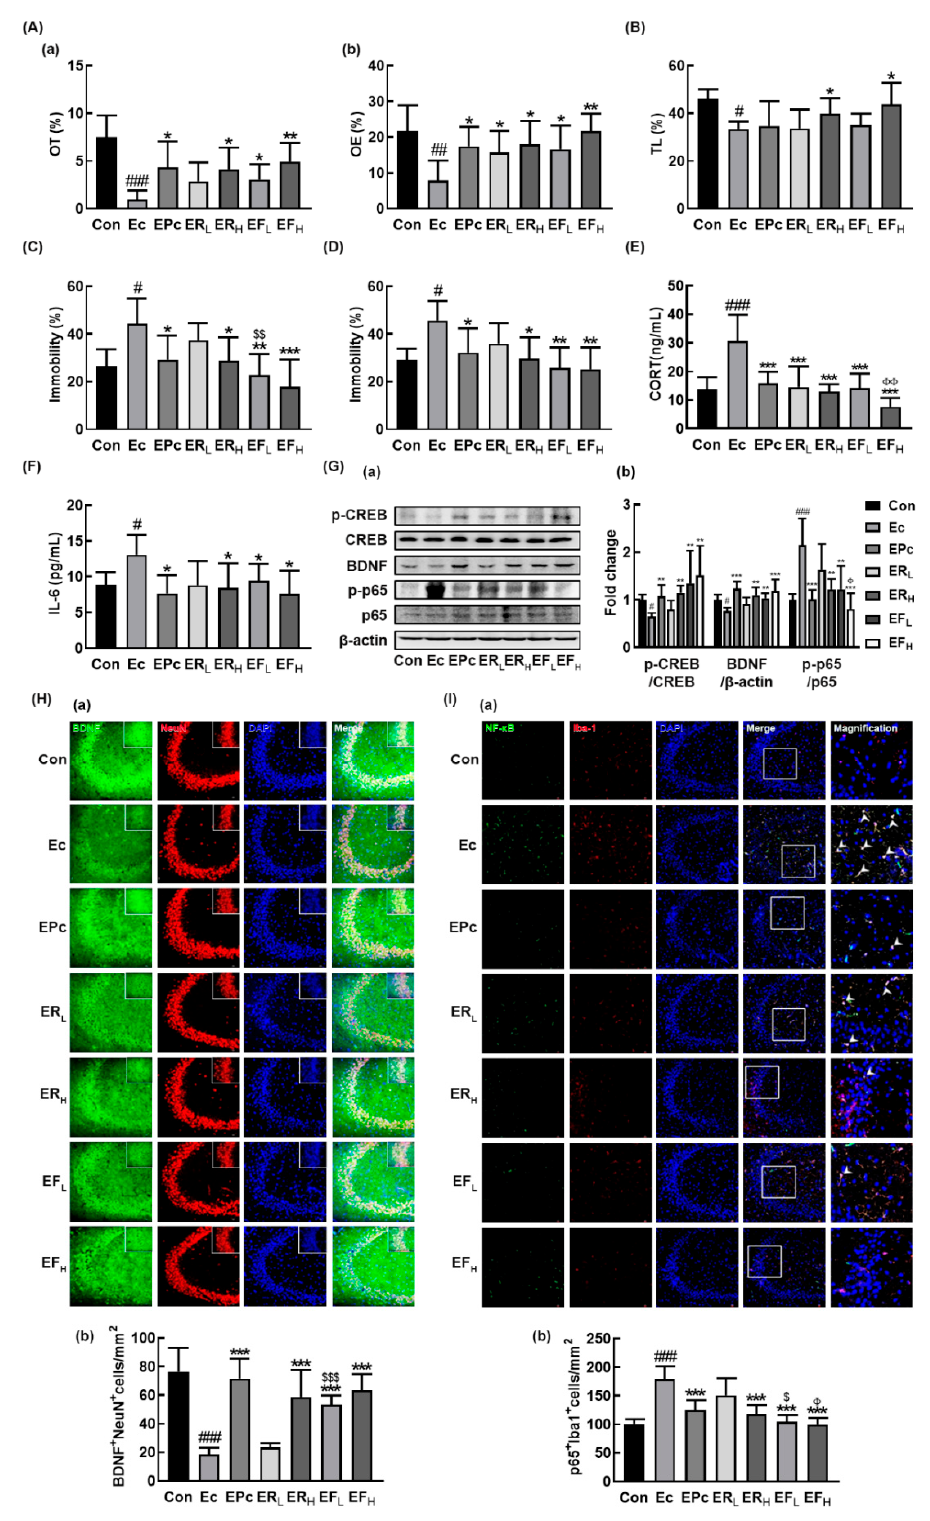
Figure 2. Oral administration of RG or fRG alleviated Escherichia coli K1 (EC)-induced anxiety / depression and colitis in mice. Effects on anxiety / depression-like behaviors in elevated plus maze ( A : ( a ), OT; ( b ), OE), light / dark transition test ( B ), forced swimming test ( C ), and tail suspension test ( D ). Effects on corticosterone (CORT, E ) and IL-6 levels ( F ) in the blood. ( G ) Effects on BDNF expression, cAMP